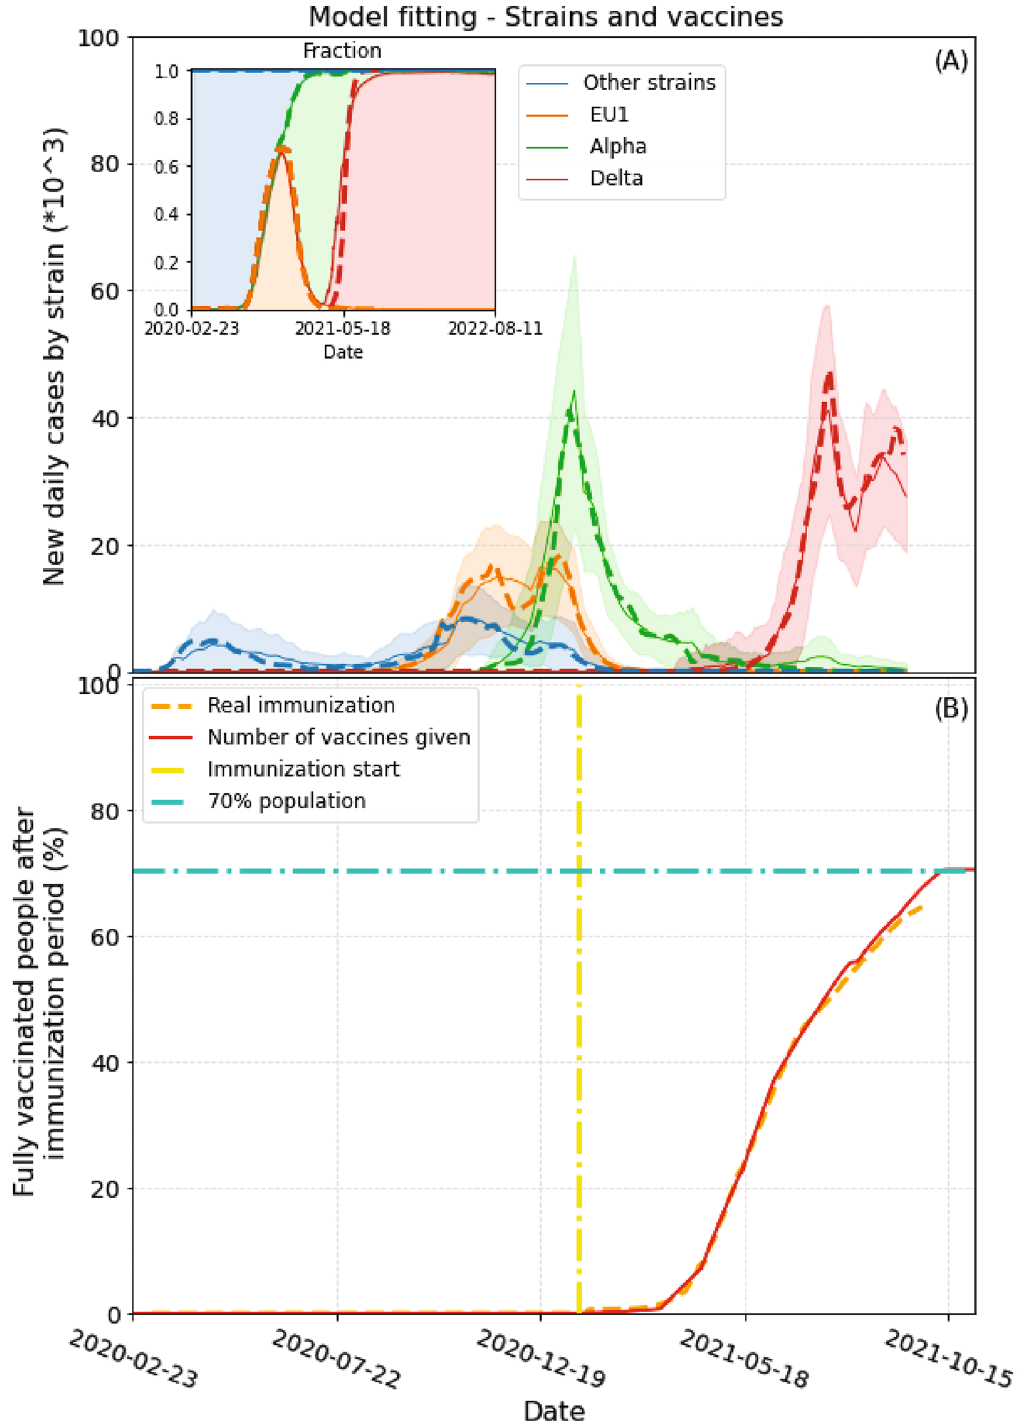
Figure 3. Model fitting to strain and vaccination data. ( A ) Daily cases differentiated by strain. Dashed lines represent actual cases of each strain (scaled). Solid lines and shaded areas represent the average and standard deviations obtained from 100 runs of the model, respectively. The inset shows the fraction of cases for each variant for a longer period of time. The Delta variant is expected to prevail if no new more contagious variants appear. ( B ) Immunization over time. Yellow dash-dot line signals the day immunization started. Red solid line represents the percentage of fully immunized people in the model in time. The dashed orange line depicts the actual two-dose vaccination data (with 14 days delay, which is the average time needed to acquire full immunity after the second